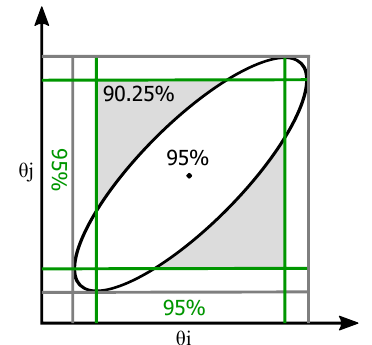
Figure 2: Comparing a simultaneous confidence ellipse for two parameters with the point-wise CIs (green) for each parameter, shows that the projections of the ellipse (grey) is wider than the point-wise CIs. Also, the combined con- fidence (0.95 × 0.95=0.9025) of both point- wise CIs together is shaded in grey. Note the difference between two combined point- wise CIs (shaded square) and the simultan- eous confidence